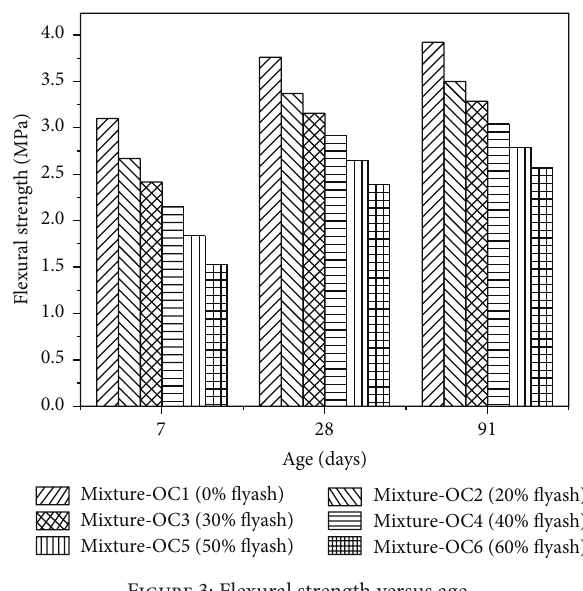
Figure 5: Mass attenuation coefficient with photon